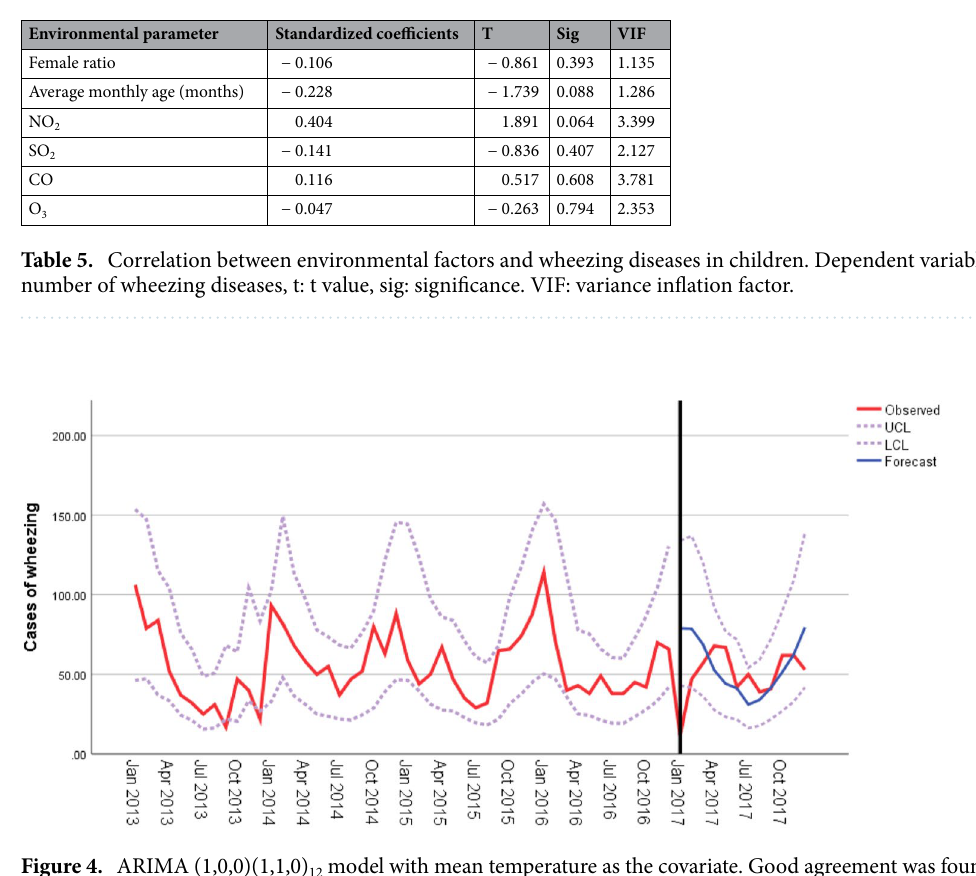
Figure 4. ARIMA (1,0,0)(1,1,0) 12 model with mean temperature as the covariate. Good agreement was found between observed and predicted wheezing diseases incidence. LCL, lower confidence interval; UCL, upper confidence interval. Figures were generated using Adobe Illustrator version CC 2018 (https:// www. adobe. com/ cn/ produ cts/ illus trator.